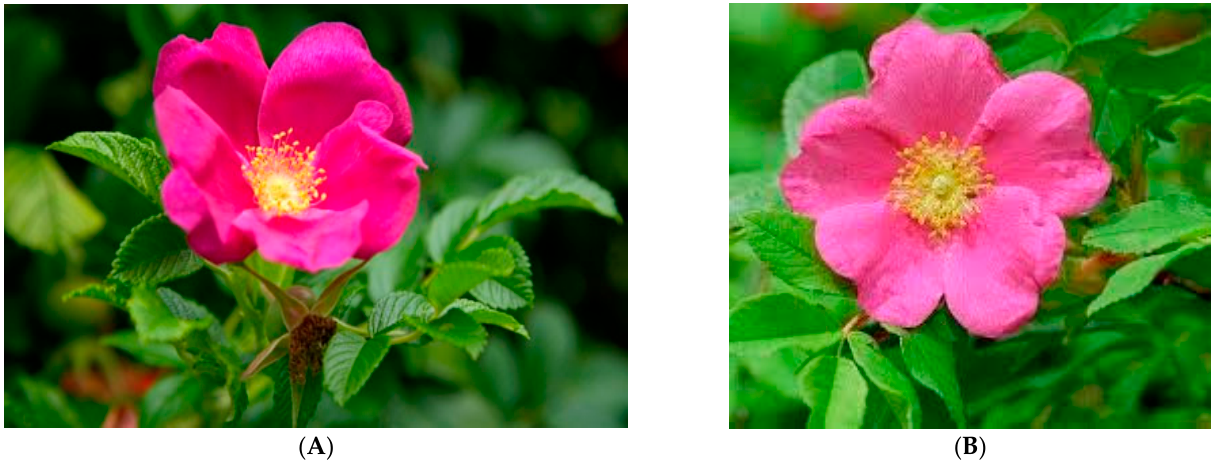
Figure 1. ( A ) Rosa rugosa (Far Eastern Russia); ( B ) Rosa davurica (Trans-Baikal region).